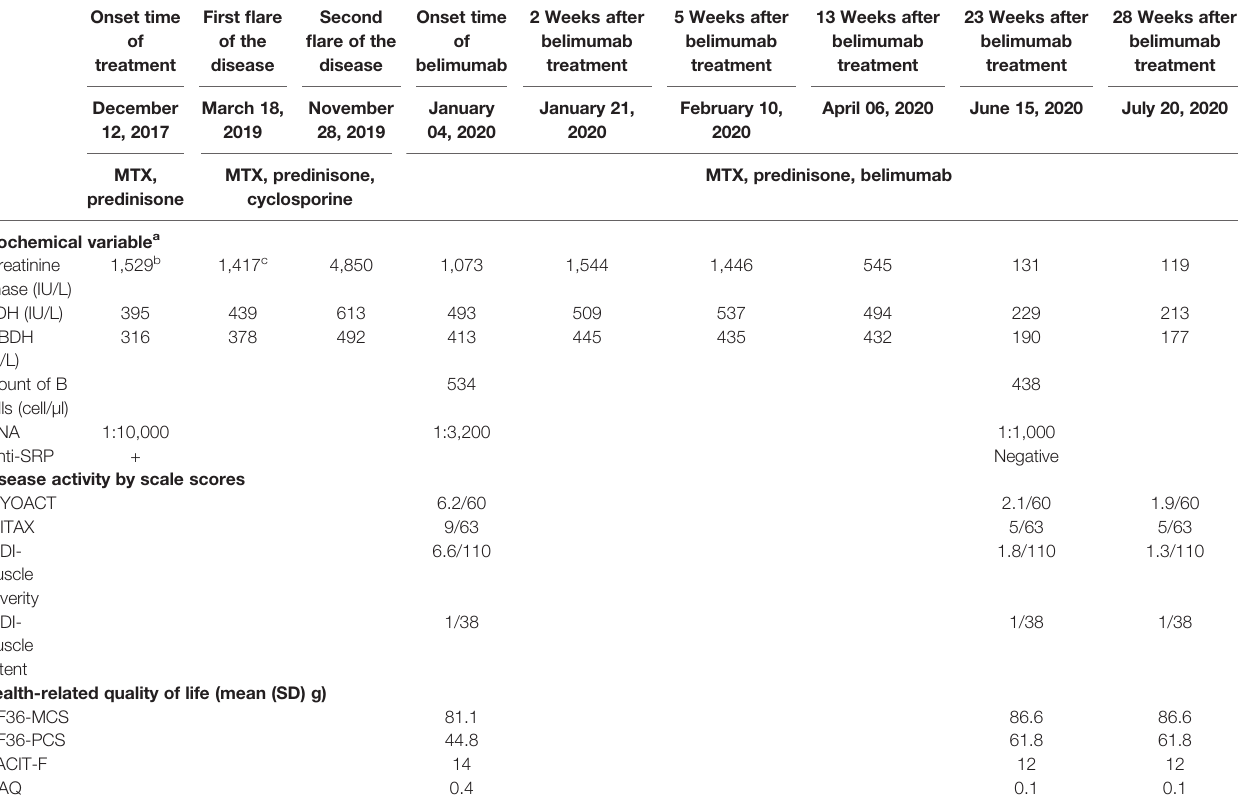
TABLE 1 | Biochemical variables and scale scores in response to different methods of immunosuppression. Onset time of